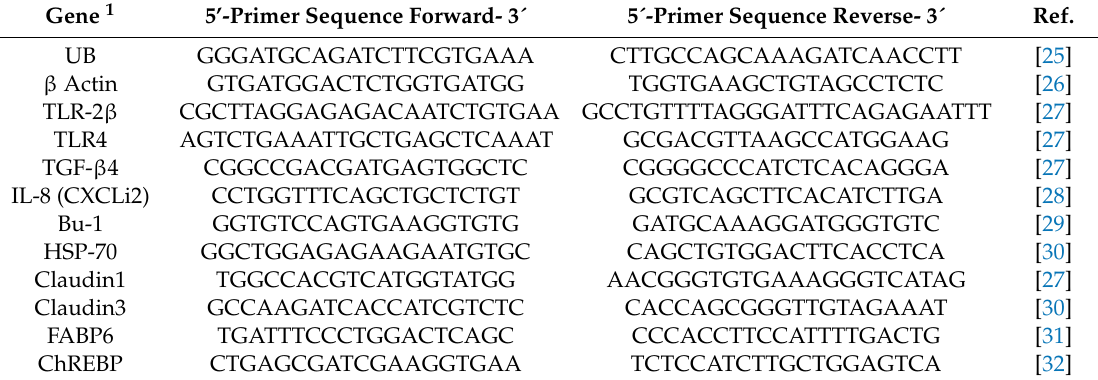
Table 2. Genes, forward and reverse primers for gene expression analysis by qRT-PCR. Gene 1